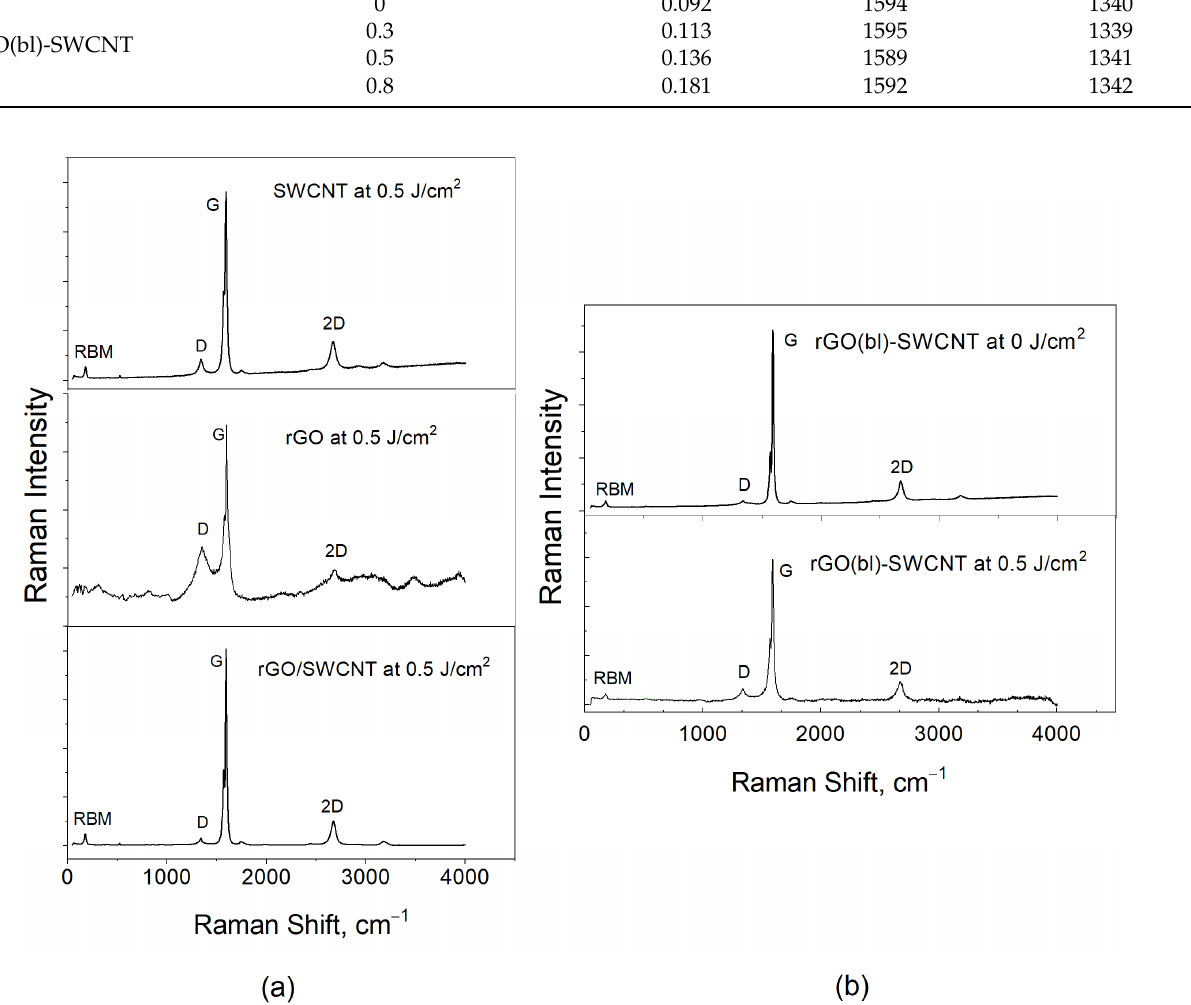
Figure 9. ( a ) Raman spectra of SWCNT, rGO, and rGO/SWCNT samples after laser exposure with an energy density of 0.5 J/cm 2 and ( b ) Raman spectra of rGO(bl)-SWCNT before and after laser exposure with an energy density of 0.5 J/cm 2 .